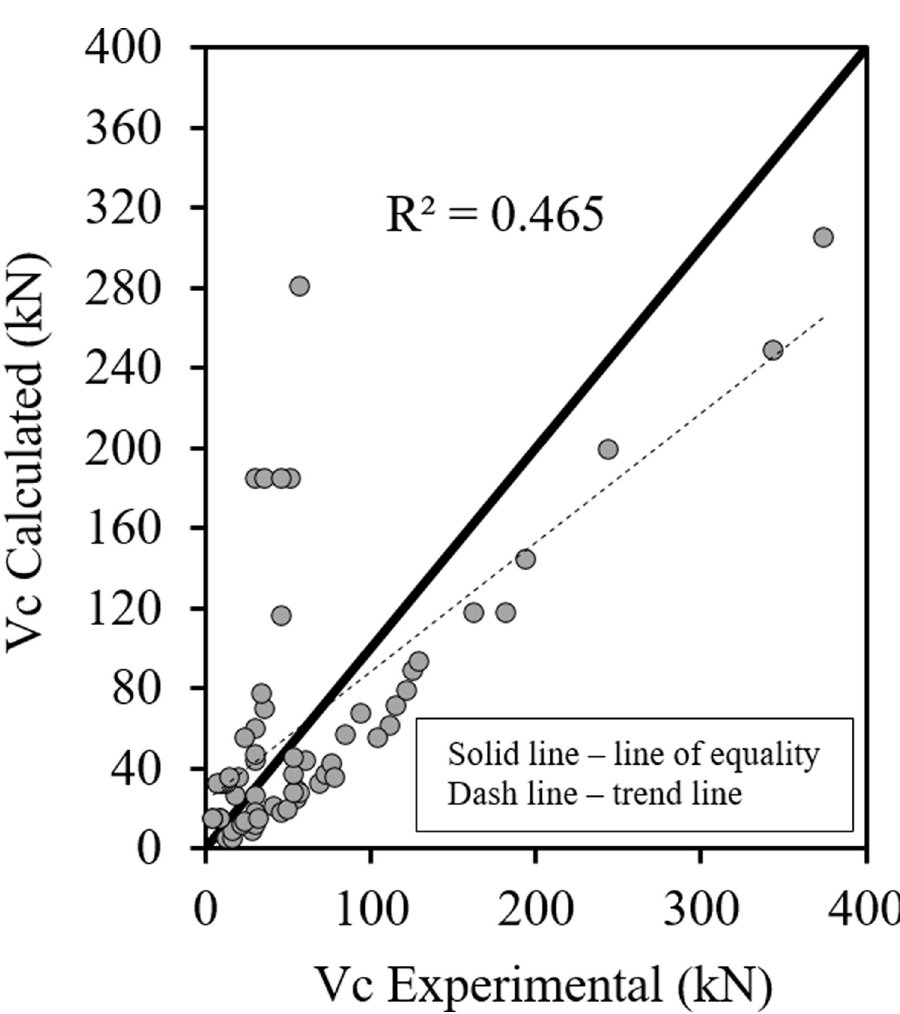
Fig 9. Shear strengh of fibrous HSC beams (Eq 12).